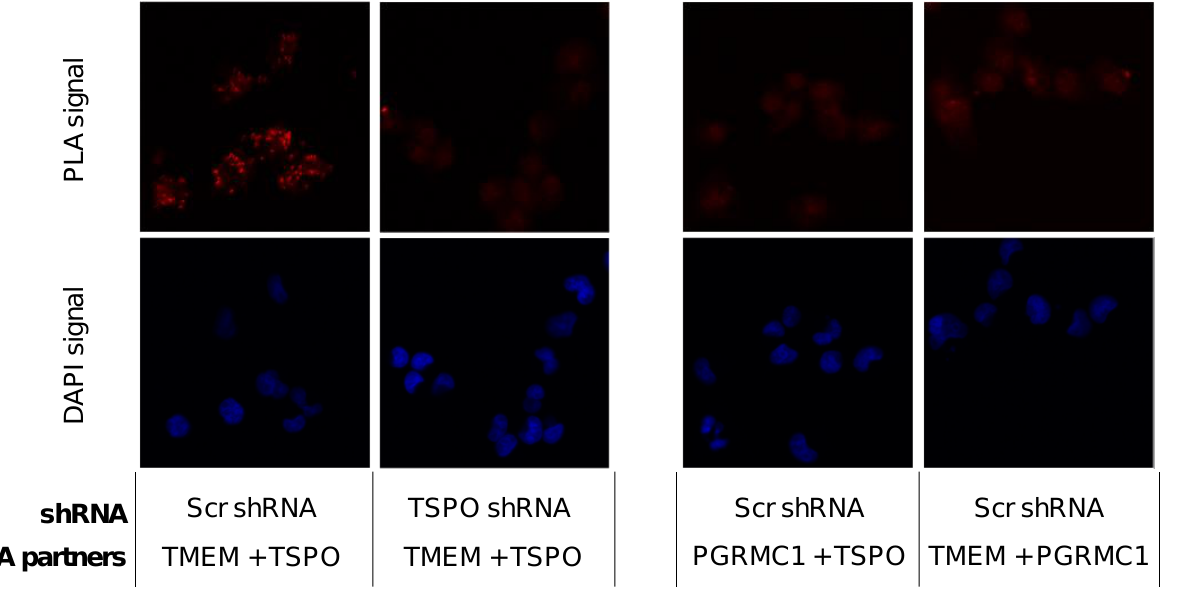
Figure 3. TSPO is colocalized with SW120 receptor S2R in MP cells. The left panels represent PLA results for TMEM97 (TMEM) and TSPO pairing. The positive signal was observed compared with the negative signal after attenuating TSPO. The right panels show two negative PLA signals for TMEM97 + PGRMC1 and PGRMC1 + TSPO. Those negative observations were similar to a negative control without primary antibodies. Red corresponds to the signal amplified by the Duolink PLA reaction described in Section 4.12. Blue represents DAPI staining of DNA. Each discrete blue patch represents one cell nucleus (imaged at 20 × magnification).